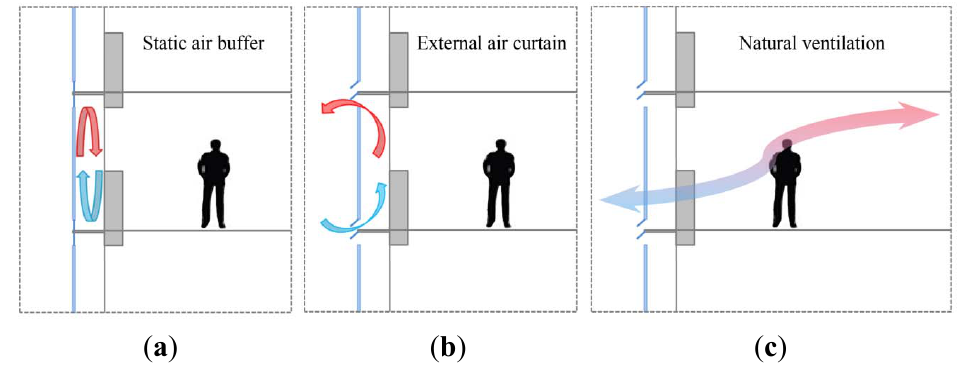
Figure 3. Seasonal airflow operating method of a DSF: ( a ) Static air buffer as